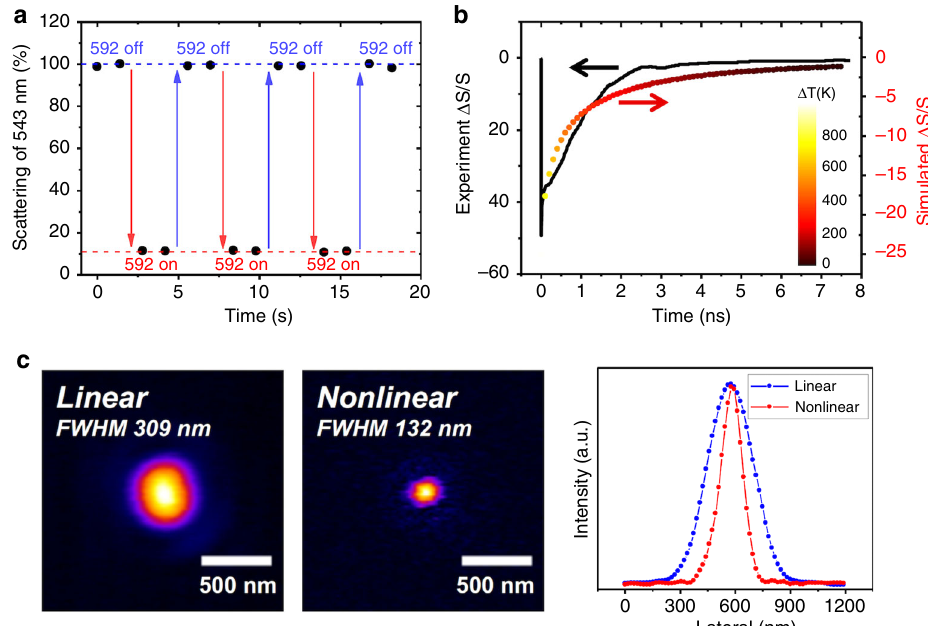
Fig. 4 Potential applications of photothermal nonlinear scattering. a All-optical switch on a single nanoblock with simultaneous illumination by a pump (592-nm) and a probe (543-nm) beams. When the pump is on, the probe scattering is ef fi ciently turned off. b Temporal evolution of scattering and temperature relaxation in a single nanoblock. The black line is the transient pump-probe experimental result, agreeing well with the simulation (colored line; colors represent temperature). Both show a relaxation lifetime of ~1 ns. c Resolution enhancement of a silicon nanostructure via nonlinearity. The size of PSF is reduced by more than 2-fold with nonlinear response. Corresponding cross-sectional line pro fi les are provided in the right